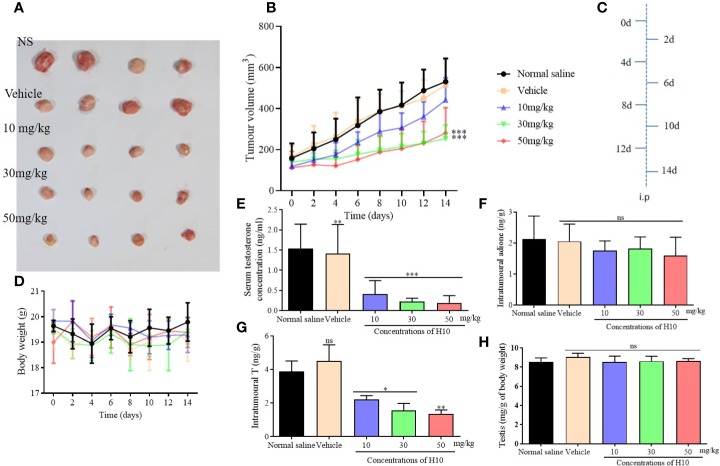
Antitumor effects of H10 at doses of 10, 30, and 50 mg/kg in LNCaP cells of the bearded nude mice model. (A) Diagrams depicting the tumor. (B) Tumor sizes. (C) Treatment schedule of the mice that were treated with drugs. (D) Body weights of the mice. T levels in the (E) serum and (G) tumor. (F) Intratumor levels of adione. (H) Testicular mass of each of the groups. The results demonstrated that treatment with H10 inhibited tumor growth, and the T levels in both the sera and tumor declined significantly. There was no significant difference in the body weights and testicular masses of the nude mice among the groups following the administration of H10 (n = 6, means ± sd, *P < 0.05, **P < 0.01, and ***P < 0.001 are considered significant vs. vehicle group, ns indicates no significant difference vs. vehicle group, P > 0.05.)